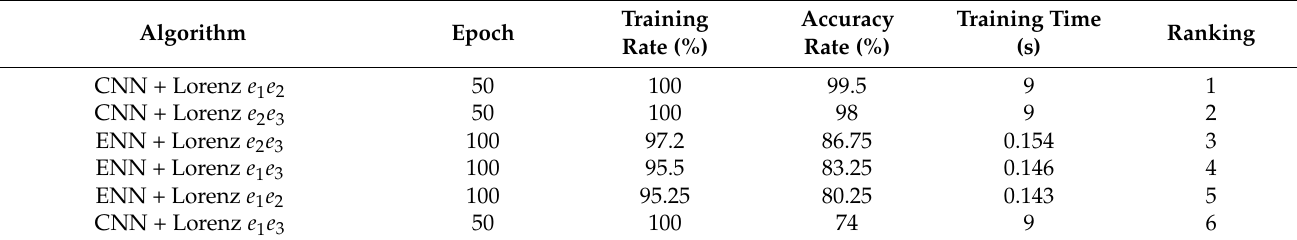
Table 2. Simulation results with different